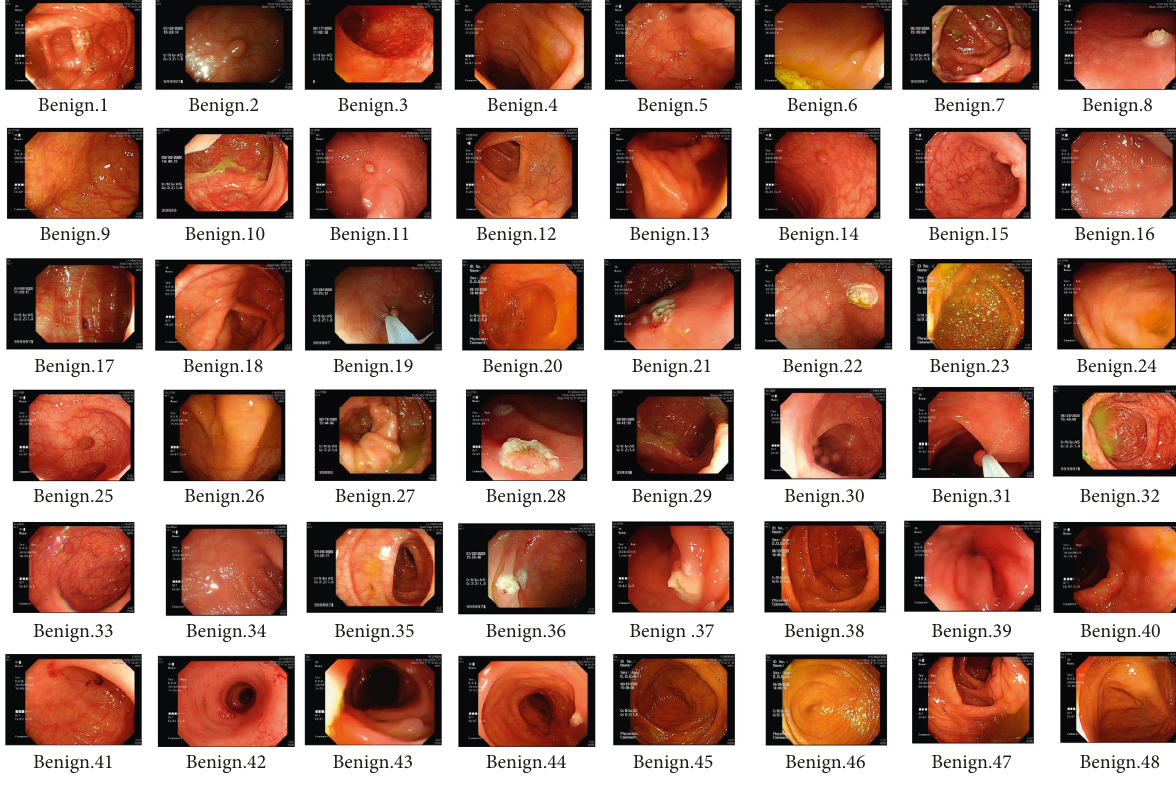
Figure 2: Benign